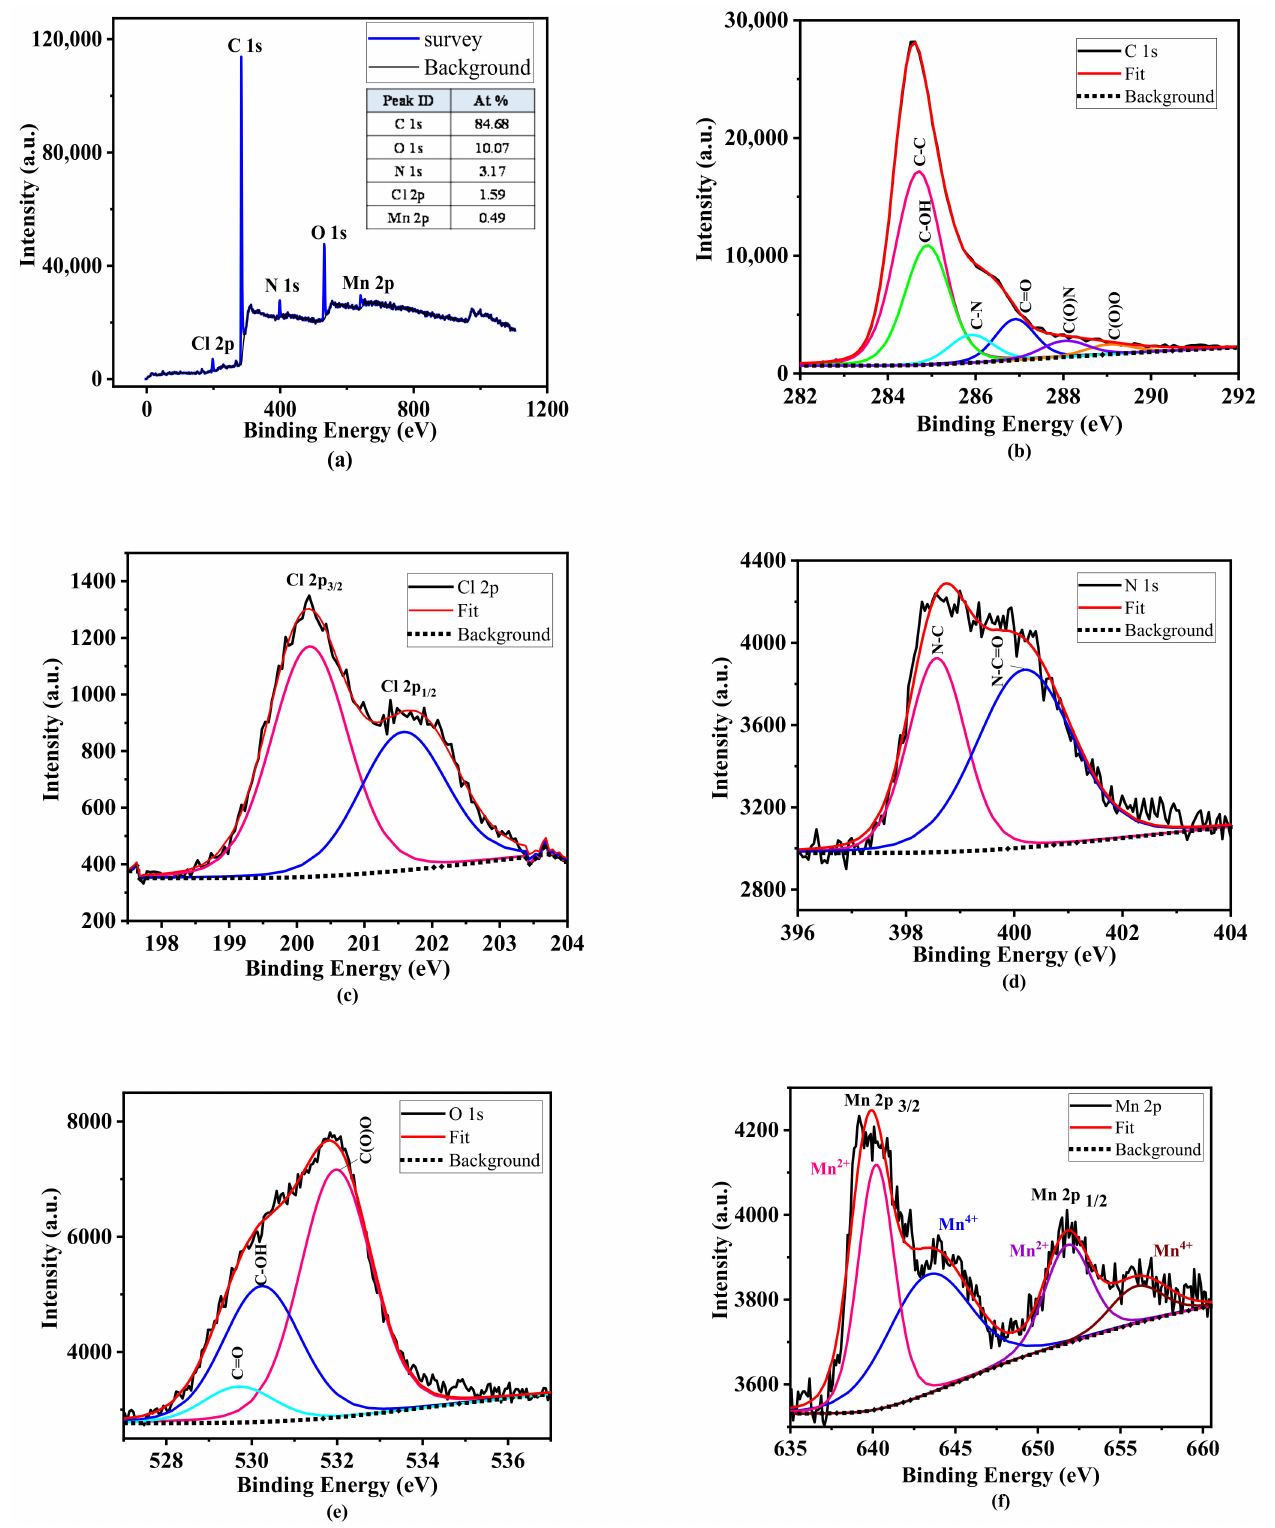
Figure 6. XPS spectroscopy (XPS) for manganese functionalized graphene oxide (m-GO), survey ( a ), xps of C 1s ( b ), Cl 2p ( c ), N 1s ( d ), O 1s ( e ), and Mn 2p ( f